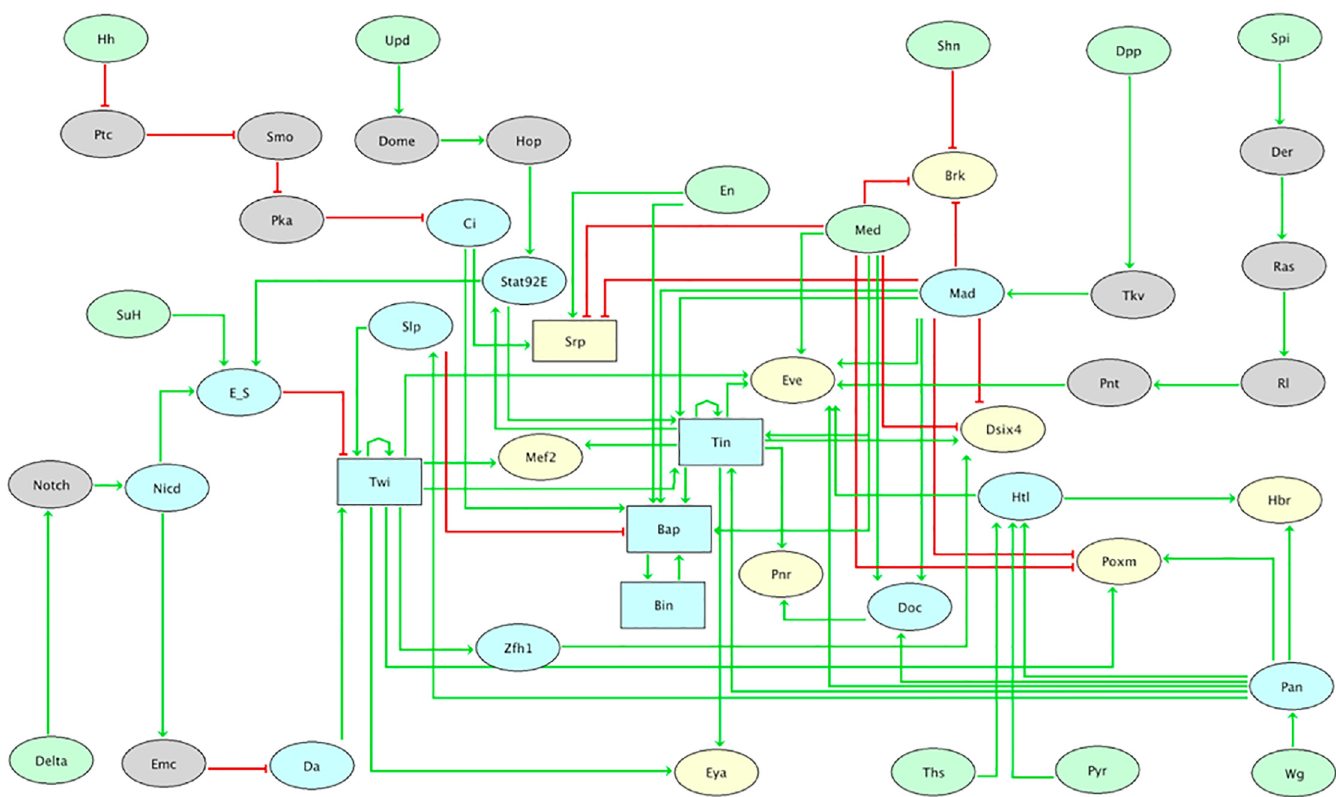
Fig 3. Regulatory graph for the signalling/transcriptional network controlling drosophila mesoderm specification. Built with the software GINsim, this regulatory graph encompasses the main regulatory factors and interactions involved in mesoderm specification (stages 8 – 10), as documented by published (molecular) genetic and functional genomic data. Ellipses denote Boolean nodes, whereas rectangles denote multilevel nodes. Light green filling denotes input nodes, most corresponding to factors expressed in and acting from the ectoderm. Yellow filling denotes output factors, mostly effector genes and tissue markers. Blue or grey filling denotes internal nodes expressed in the mesoderm. Green arrows and red blunt arrows denote activations and inhibitions, respectively. Logical rules are further associated with each node to define its behaviour depending on regulatory inputs (cf. S1 Table). To ease the dynamical analysis of this regulatory graph, we performed a reduction of this regulatory graph (cf. Material and methods), making implicit the twelve grey components. This logical model is provided as supporting data, including comprehensive annotations and bibliographical references.